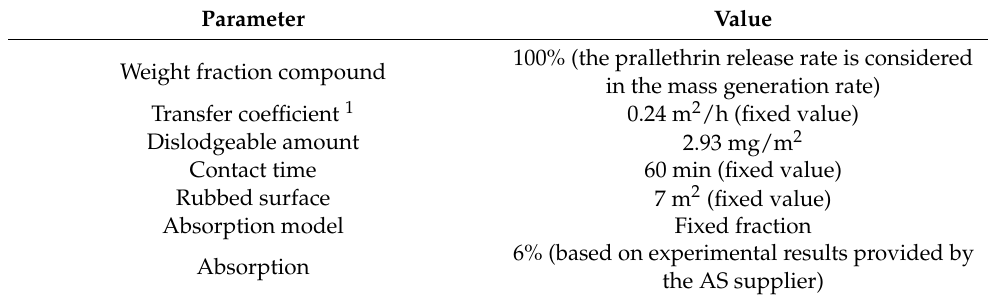
Table 2. Summary of parameters for the ConsExpo model “Dermal exposure: direct contact with product—rubbing